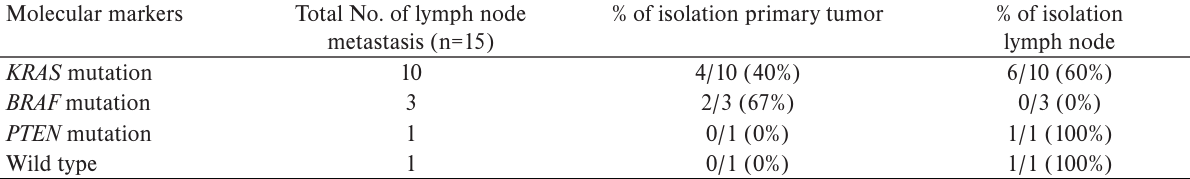
Table 3. Molecular characteristics of primary colon cancer and lymph node metastasis according to the percentage of succesful isolation of corresponding cancer cells.